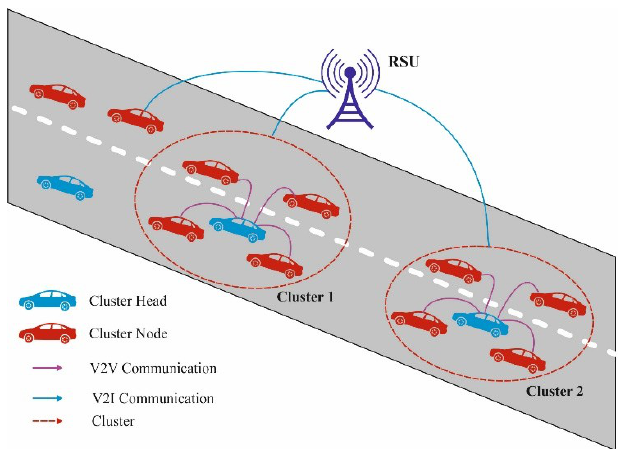
Figure 1. General cluster-based Vehicular ad hoc networks (VANET) architecture. RSU: roadside units.